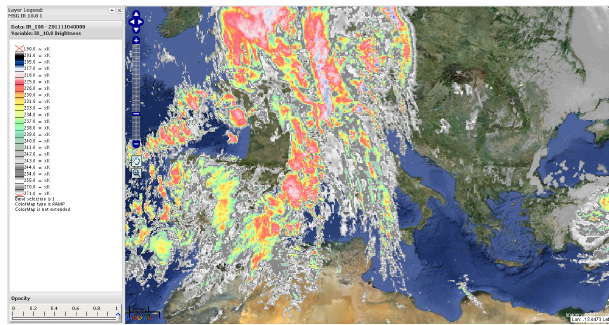
Fig. 4. Infrared temperature image at 00:00UTC, 4 Novem- ber 2011. The synoptic scale frontal system affecting western Eu- rope is shown.